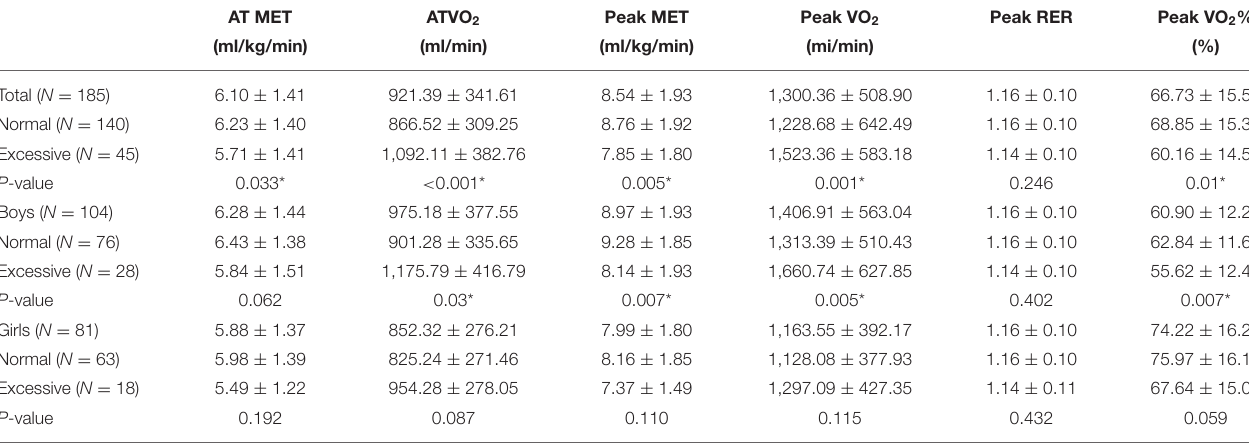
TABLE 3 | Comparisons of cardiopulmonary fitness between patients with repaired tetralogy of fallot with normal and excessive body adipose (BMI group). AT MET ATVO 2 Peak MET